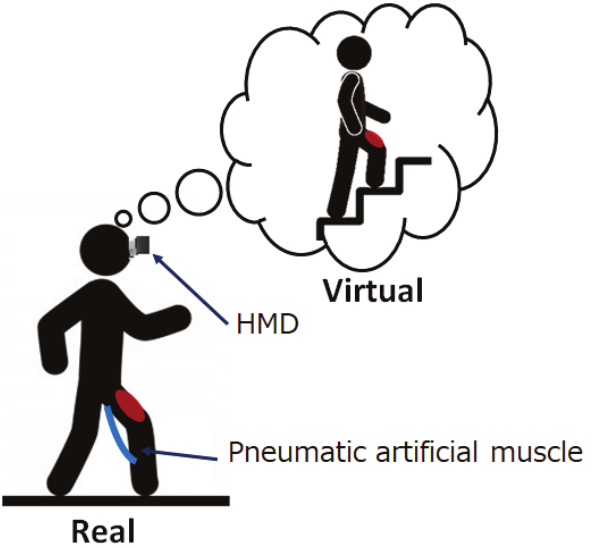
Figure 1. Illusionary stair-climbing induced by a system with visual and force